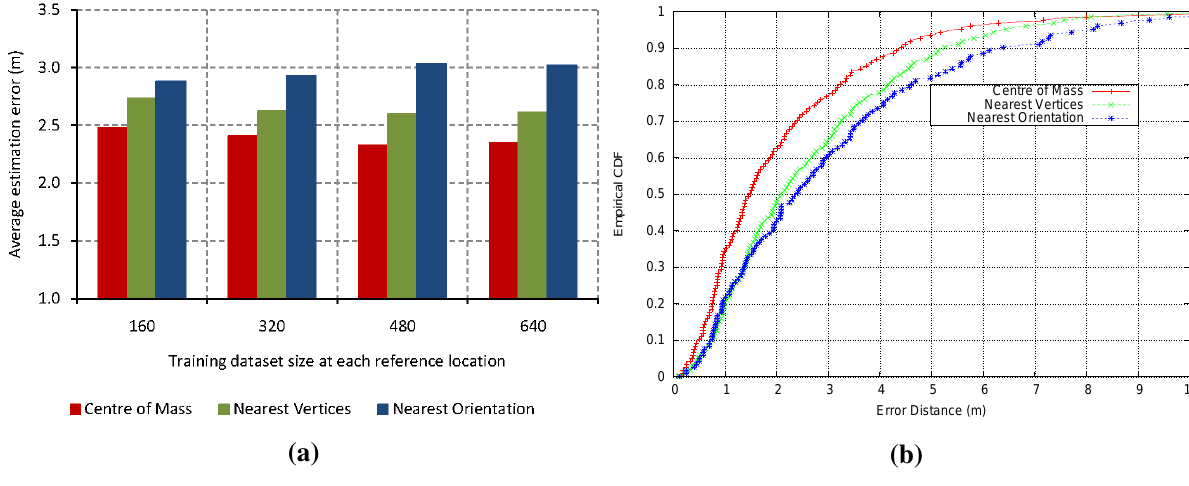
Figure 2. Evaluation of center of mass, nearest vertices and nearest orientation methods: ( a ) location estimation error; ( b ) CDF of